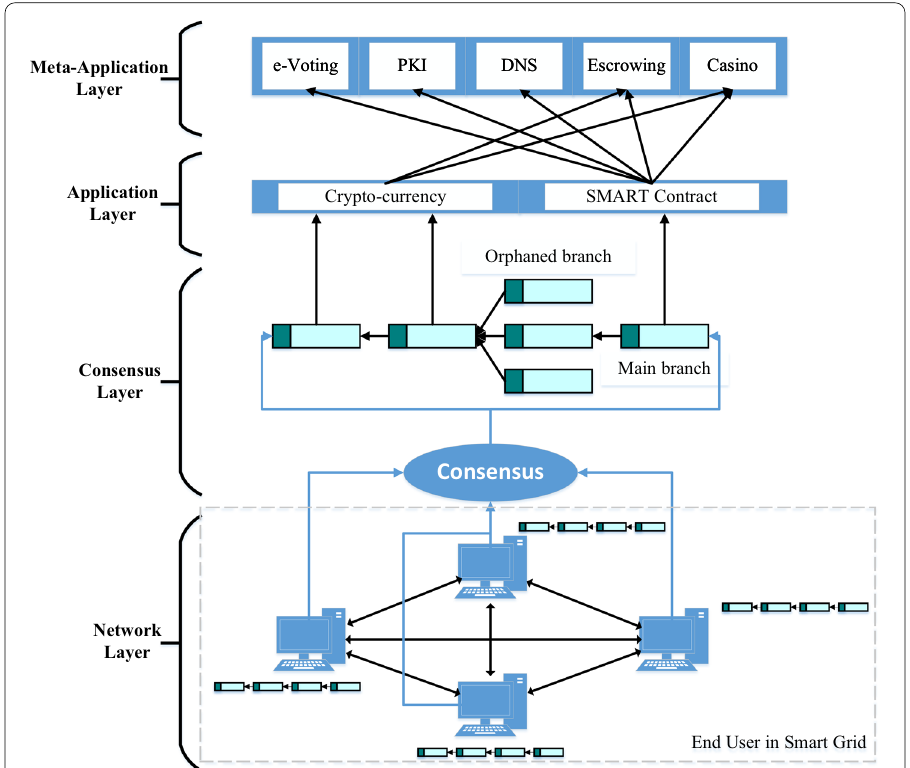
Fig. 3 Blockchain Layers; Illustration of the Blockchain